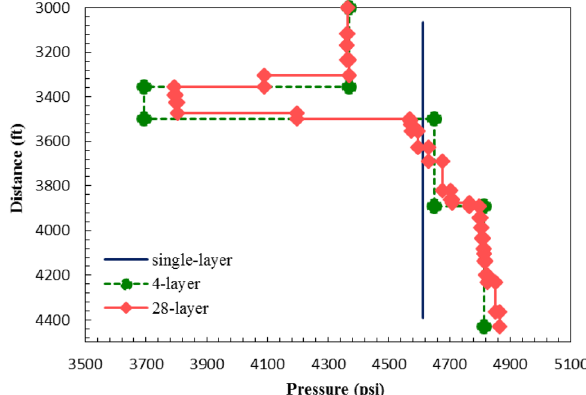
Fig. 6 Average pressure distribution of reservoir layers with